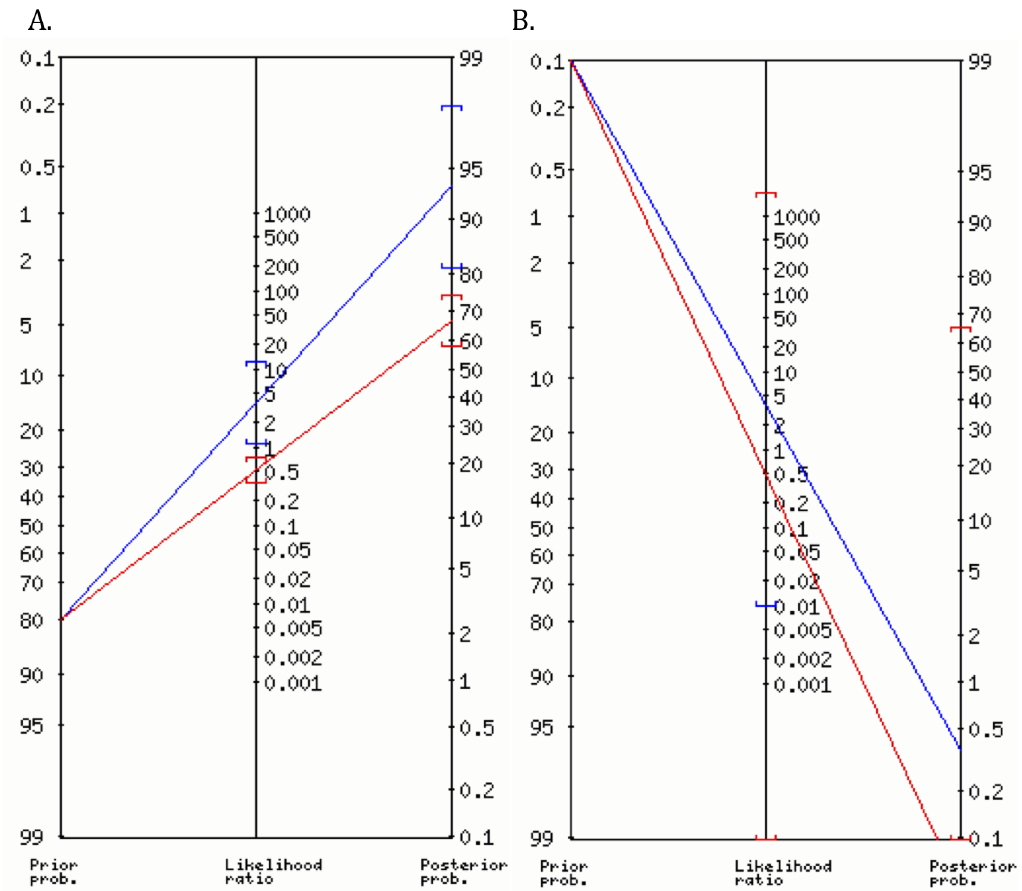
Fig 2. Fagan nomogram. Fagan nomograms. The figures show the change in posterior probability after the NIRS VOT. The test was considered positive if the delta tissue oxygen index was < 15.2. The positive and negative log-likelihood ratios were 3.67 and 0.51. Panel A. The ‘prior’ was set at 0.8. The 95% confidence interval for the positive and negative log-likelihood ratios were (1.1–12) and (0.35–0.73). Panel B. The ‘prior’ was set at 0.001. The 95% confidence interval for the positive and negative log- likelihood ratios were (0.01–1901) and